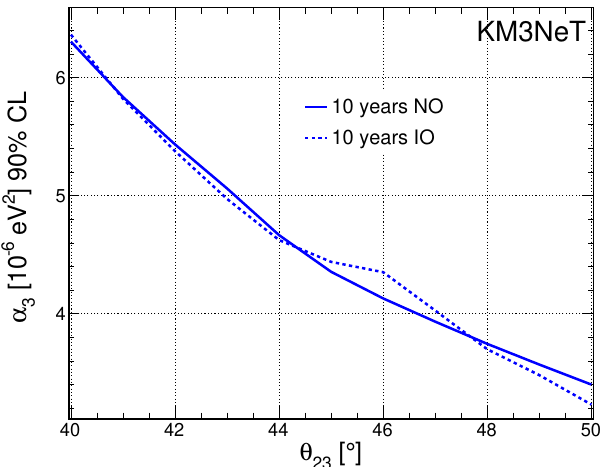
Figure 10. 90% CL upper limits for α 3 in KM3NeT/ORCA after 10 years of data taking assuming NO (solid) and IO (dashed) as a function of the true value of θ 23 .